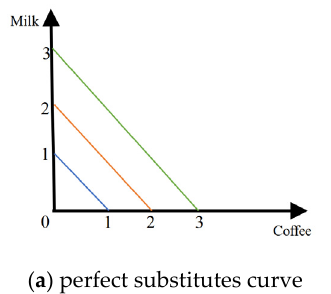
Figure 5. Indifference curve.